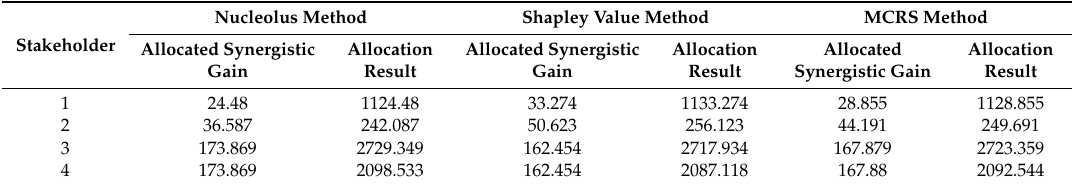
Table 2. Allocated synergistic gains and allocation results